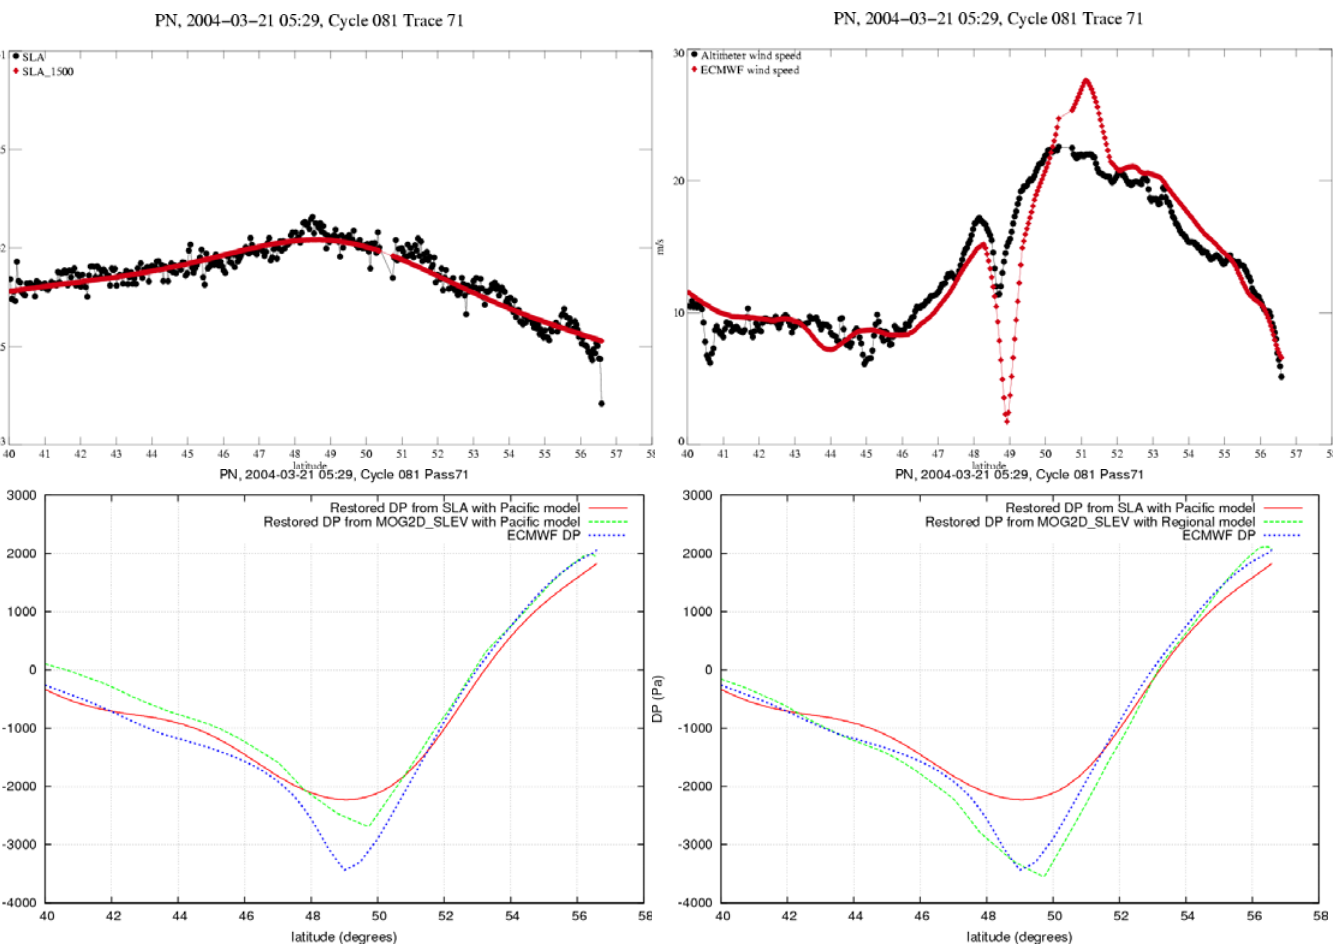
Figure 17. Case of 21/03/2004 over the North Pacific Ocean – J1 cycle 81 – track 71. Along-track plots, abscissa is latitude. (a) SLA in black and filtered SLA in red (cm, upper left panel); (b) ECMWF wind speed in red and altimeter wind speed in black (m.s -1 , upper right panel); (c) ECMWF DP in black, altimeter-restored DP from global model in red and from barotropic model global analysis in green (Pascals, lower left panel); (d) same as (c) with green line showing DP from the regional regression model (Pascals, lower right